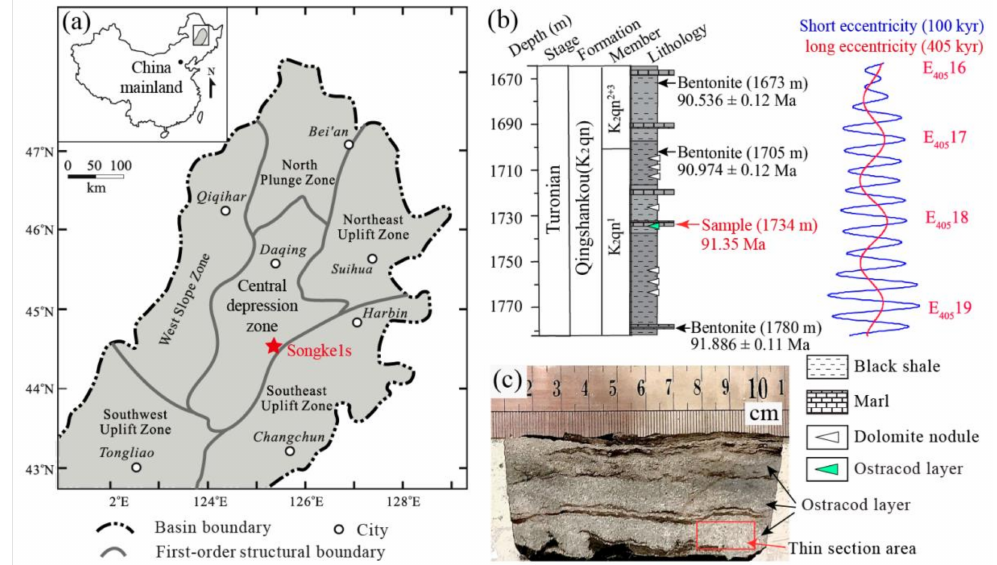
Figure 1. ( a ) Location of the Songke1s core in the Songliao Basin, northeast of China. ( b ) Stratigraphy, geochronology, and astrochronology of the Songke1s core in the 1782–1667 m range. The sample age (91.35 Ma) in this study was calculated from the high-precision U-Pb zircon ages [23] and the critical astronomical time scale tune by short eccentricity [24,25]. ( c ) Hand specimen characteristic of the studied ostracod layer. Thin sections were prepared from the area without organic-rich